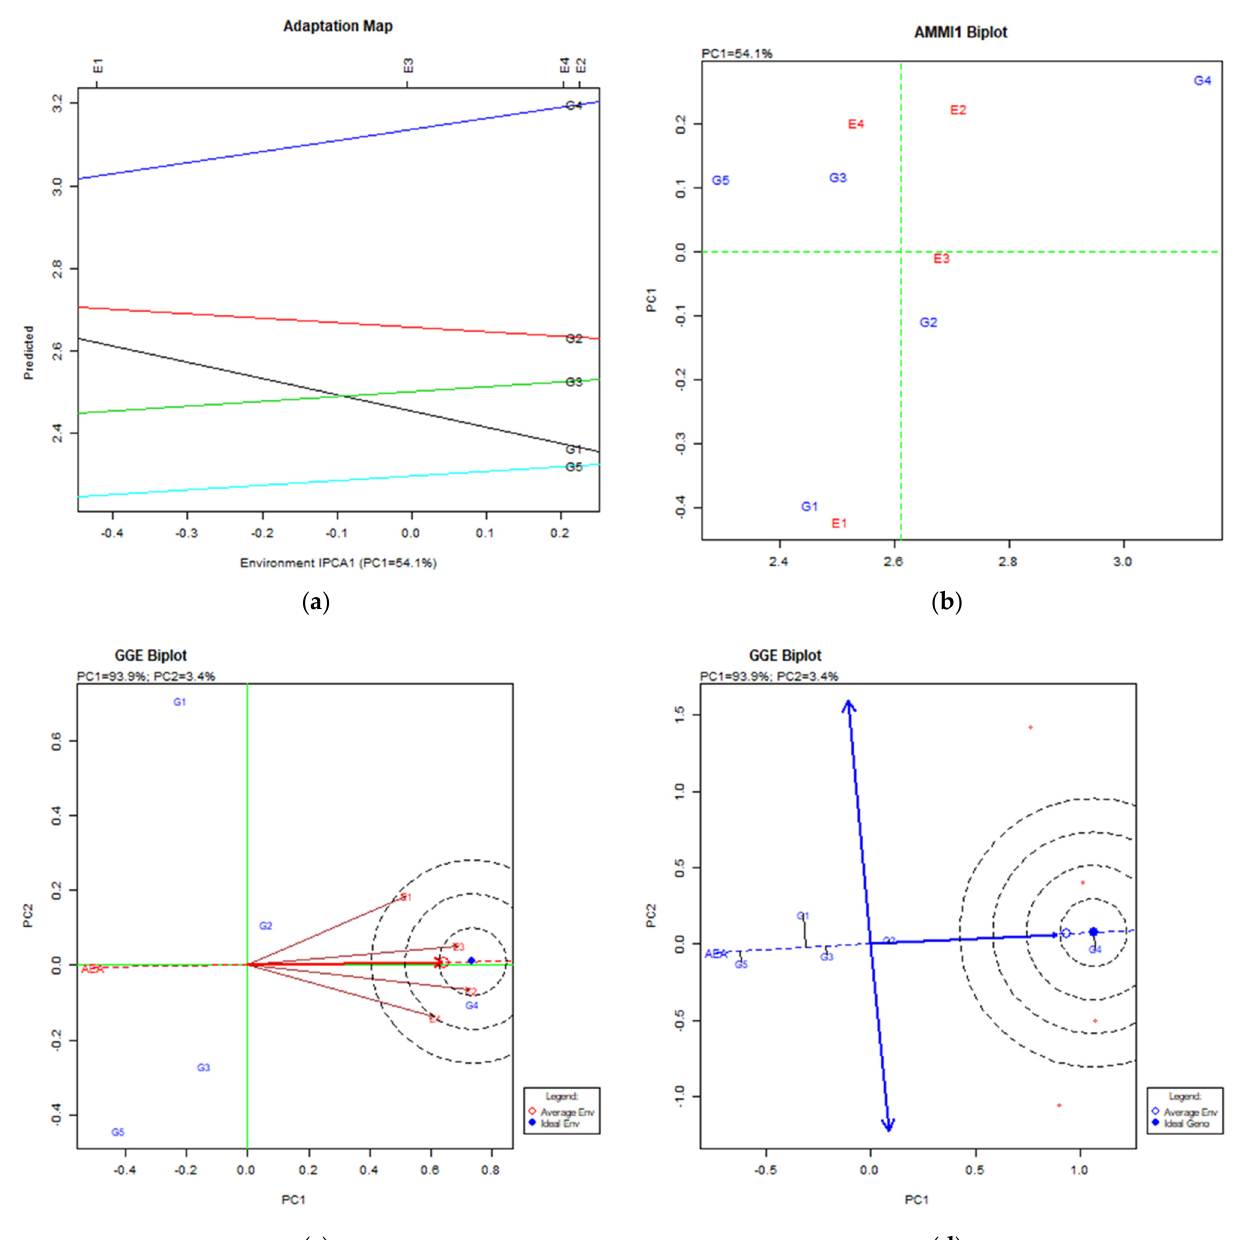
Figure 10. Stability analysis for number of branches based on: ( a ) the adaptation map where the X-axis (PC1) visualizes the stability of cultivars over environments and the Y-axis—the performance of cultivars for the trait; ( b ) the AMMI1 biplot where the Y-axis is the one visualizing the trait performance and the X-axis (PC1) visualizes the stability of cultivars over environments; ( c ) the GGE biplot for environments depicting the stability of the environments over years via the placement as near as possible to the ideal and average environment; ( d ) the GGE biplot for cultivars depicting the stability of the cultivars over environments where the productive cultivars are those to the right on the AEA vector and the stable ones are those which are as close to the AEA axis as possible.